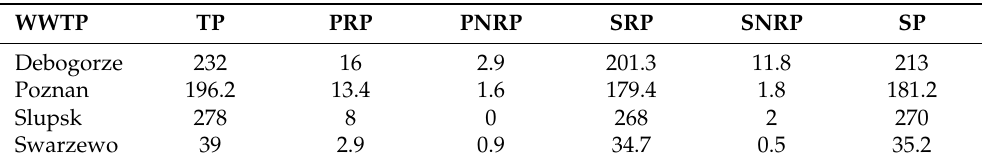
Figure 3. The percentage of phosphorus fraction in reject water from 4 WWTP: ( a ) Debogorze, ( b ) Poznan, ( c ) Slupsk, and ( d ) Swarzewo. Table 4. The concentrations of phosphorus forms in reject water from 4 WWTP, mg P-PO4/dm 3 average values, n =